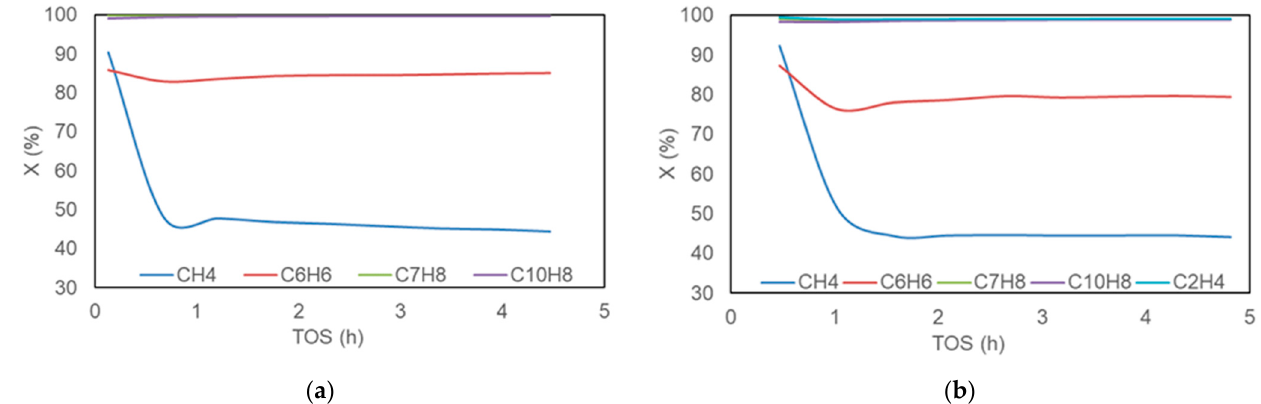
Figure 3. Hydrocarbon conversions as a function of operation time in ( a ) run 7 with rhodium catalyst and ( b ) run 13 with nickel catalyst. Reaction conditions: atmospheric pressure, 50,000 vol-ppm ethylene, 900 °C, TOS 5 h, and gas composition 1. Ethylene is not presented in ( a ), as the conversion was 100% through the test run.